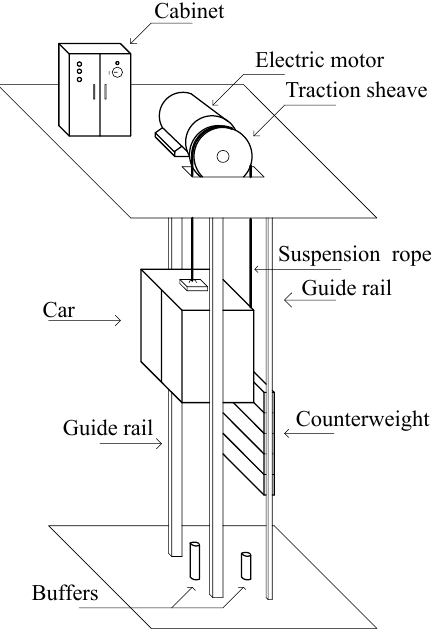
Figure 1. Elevator